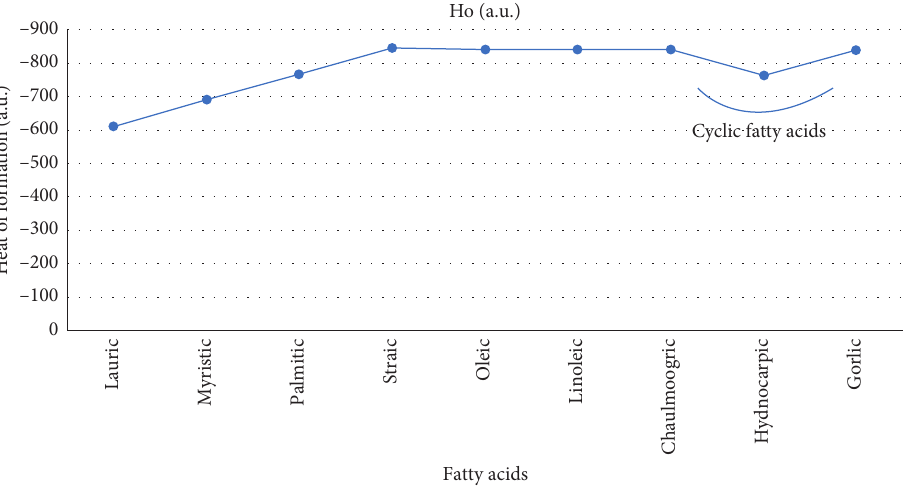
Figure 14: The heat of formation of various fatty acids.